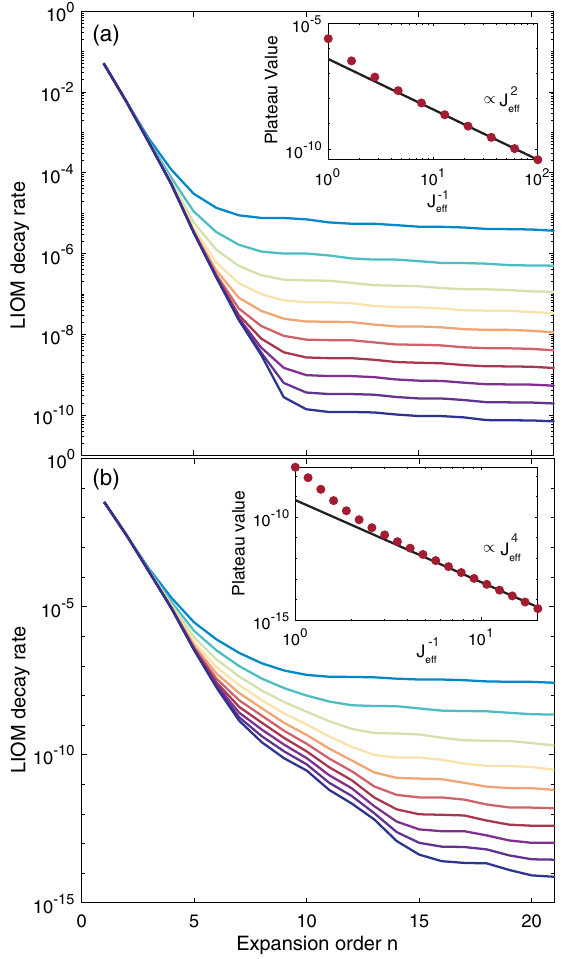
FIG. 4. Variational LIOM decay II. (a) Residual decay rate of the n th-order variational Birkhoff approximation of the integral of motionassociatedwith the impurity spin.The chain has aweaklink J after every third site, and the external impurity field is V ¼ 3 ; eff color goes from blue to red with decreasing J ranging from 1 to eff . (b)The same 100. The inset shows the plateau value scaleslike J 2 eff decayrateforanimpurityfieldof V ¼ 4 ,withtheinsethighlighting the plateau value now scaling as J 4 , ranging from 1 to eff